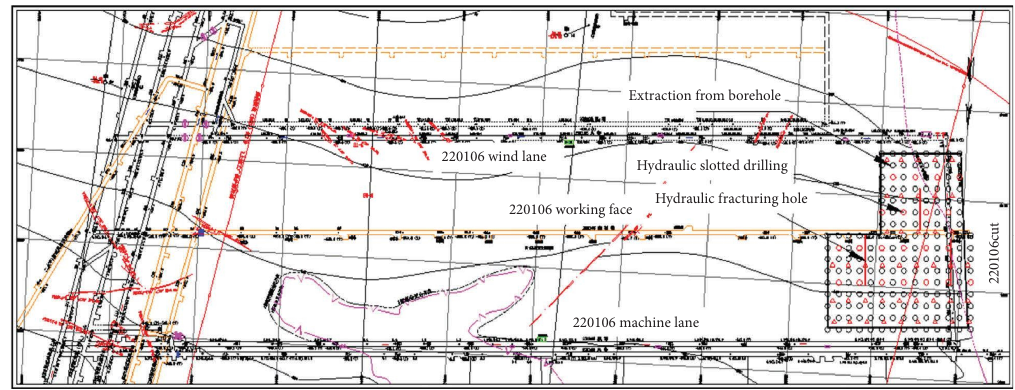
Figure 15: Pressure before cutting combined measures foor plan.